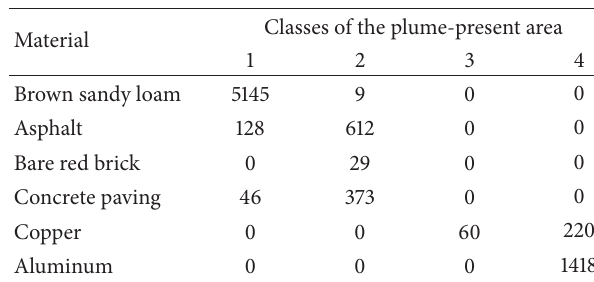
Figure6:SyntheticrefineryscenewithaGaussianplumeofSO 2 and NH 3 . Image in RGB colors, representing the bands (R: 820 cm −1 , G: 965 cm −1 , and B: 1165 cm −1 ).